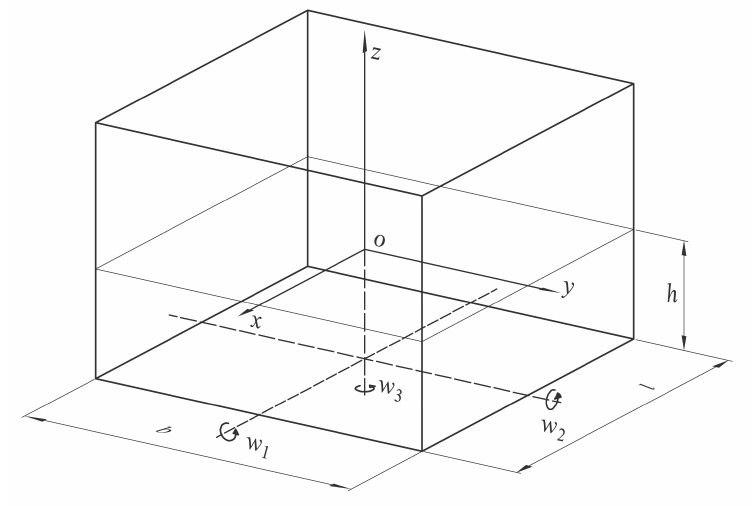
Figure 1. The coordinate system and rotation axis in a tank